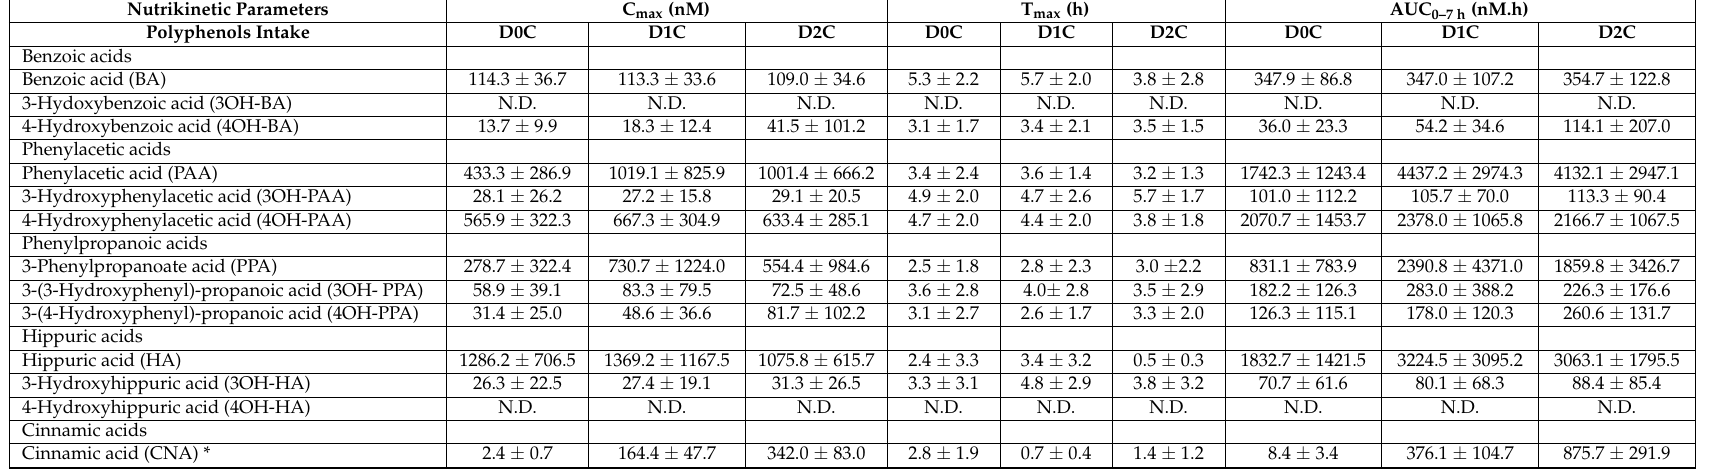
Table 1. Plasma nutrikinetics of terminal aromatic acid pathway metabolites after consumption of control 0 g (D0C), 6 g (D1C), and 12 g (D2C) of mixed spices. C max , normalized maximum concentration obtained in plasma (nM); T max , time (h) when C max was reached; AUC 0–7 h , normalized area under the curve over time (nM.h) until 7 h; N.D., not detected. Results are expressed as mean ± standard deviation ( n = 20 for D0C and D2C; n = 17 for D1C). * One outlier (Figure S3) was omitted from nutrikinetic analysis of cinnamic